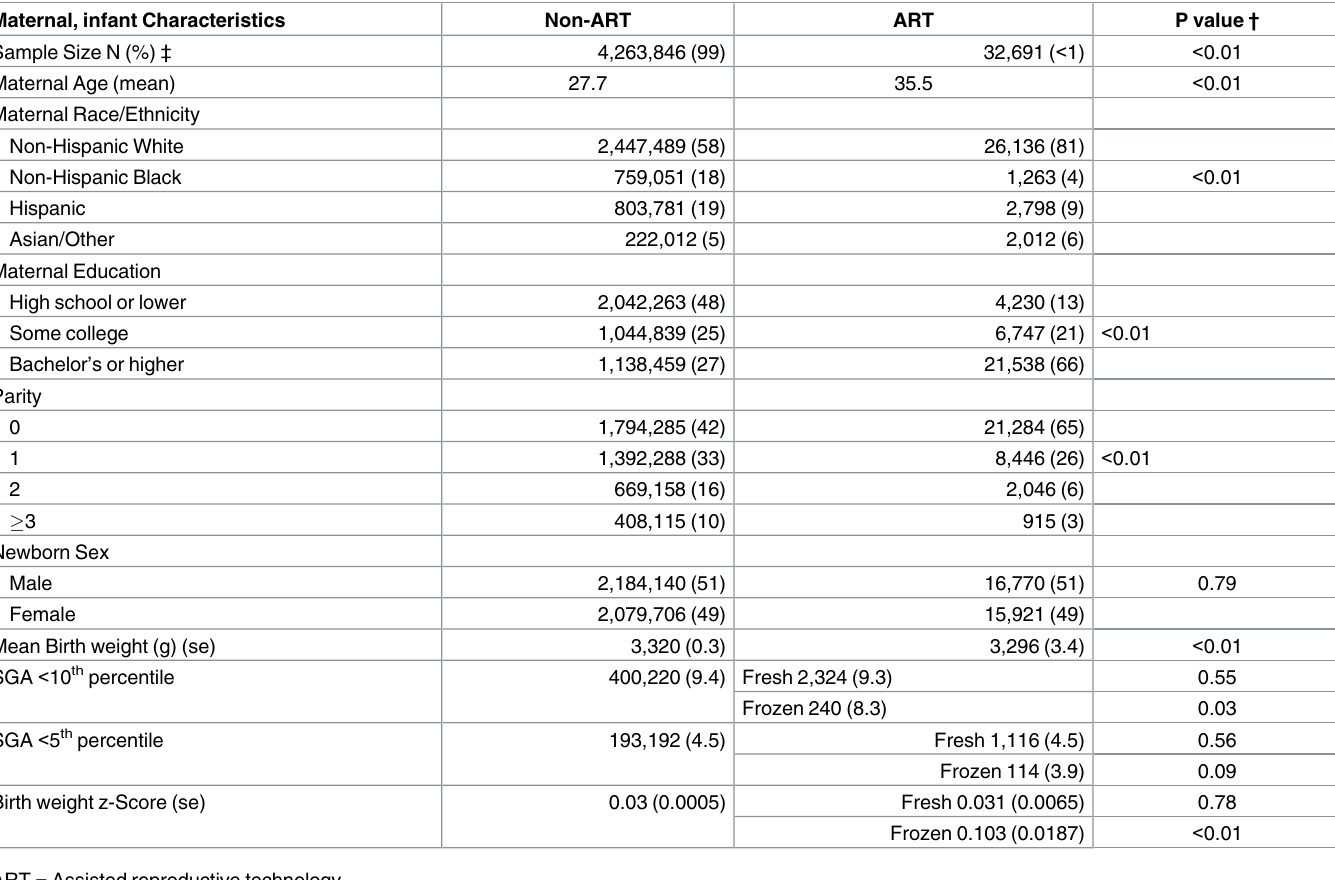
Table 1. Maternal and infant characteristics for fresh and frozen autologous ART cycles and non-ART singleton live births in Massachusetts and Florida 2000–2010and in Michigan 2000–2009: After exclusion of implausible birth weight for gestational age. Maternal, infant